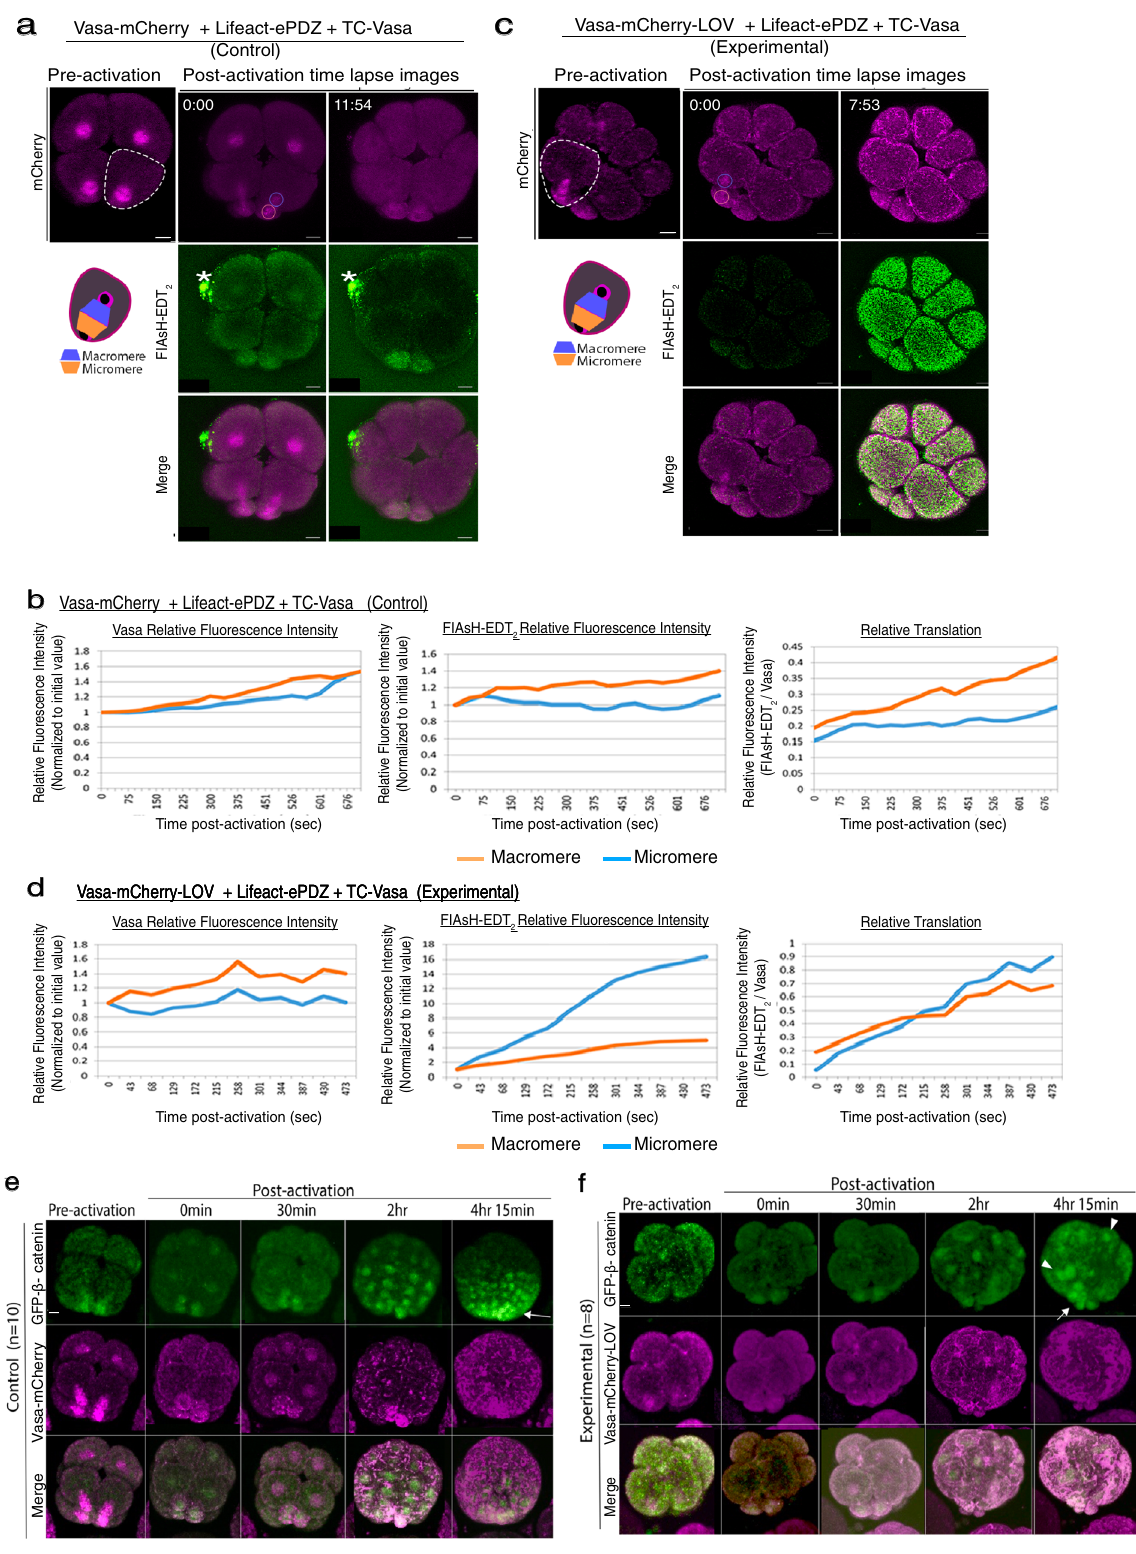
pole, assisting the establishment of the animal-vegetal axis in the embryo 46,47 . Nanos becomes enriched into the germline during early embryogenesis (5~36 hpf), contributing to germline speci fi cation 48 . In the light-activated embryos, however, proper localization of both nuclear β -catenin and Nanos was altered